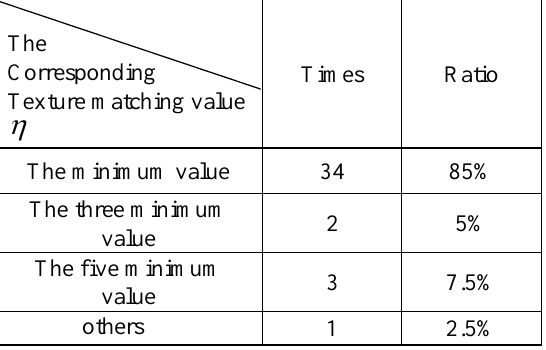
Table Ⅰ . The texture matching by DCT